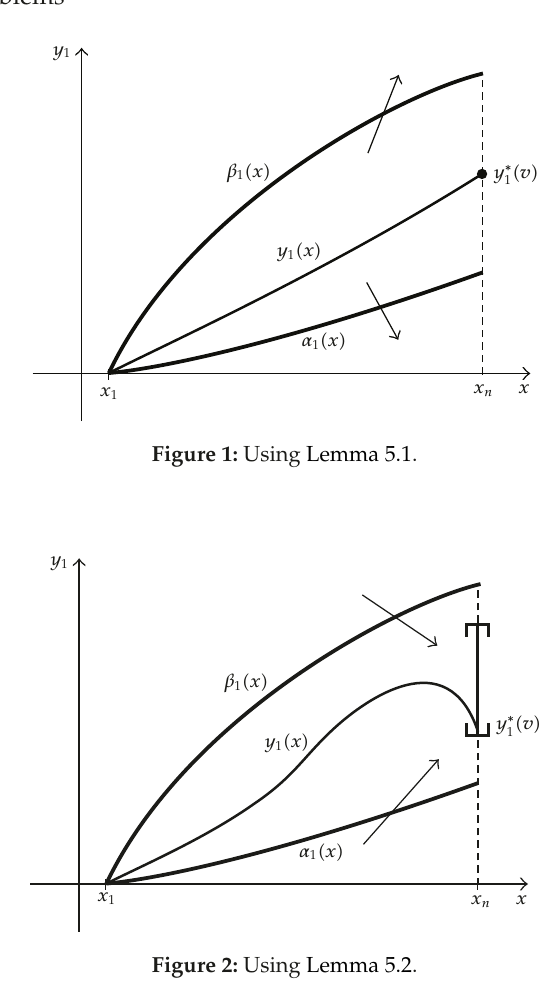
Figure 2: Using Lemma